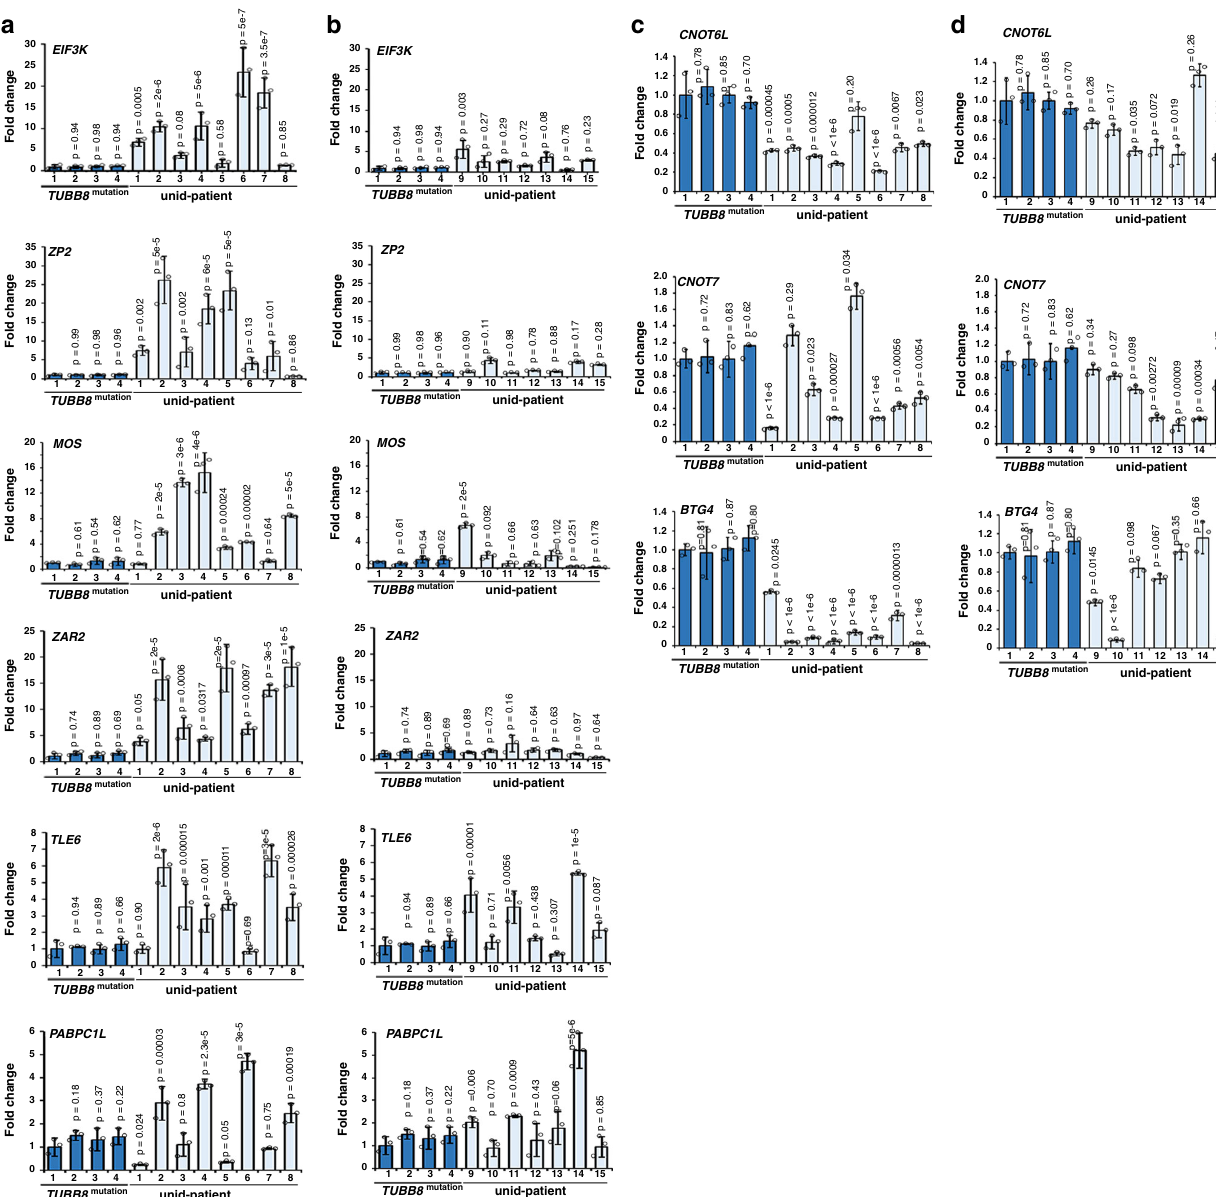
mutations. The zygotes from these women were arrested at the 1- cell stage and exhibited defects in maternal mRNA degradation. The phenotypes were similar to those we have observed in Btg4 knockout mice 41 . The identi fi cation of BTG4 mutations in infertile women supports our hypothesis that BTG4/CCR4-NOT- induced mRNA deadenylation is involved in the regulation of maternal mRNA stability during human MZT. Also consistent with our working model, TUT4/7 expression and Z-decay of maternal transcripts was impaired in human 8-cell embryos derived from 3PN zygotes, when YAP – TEAD4 activity was inhibited. These results provide evidence that YAP and TUT4/7 are likely regulating Z-decay of maternal mRNA during human MZT.